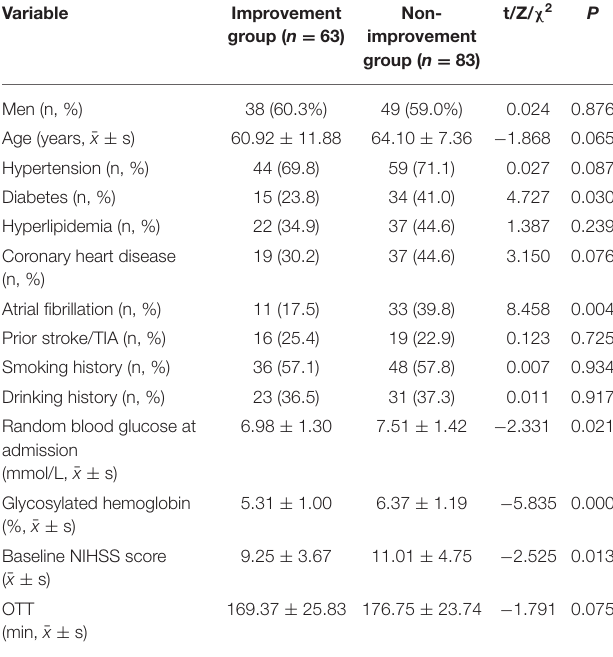
TABLE 1 | Baseline data for the improvement group and non-improvement group.